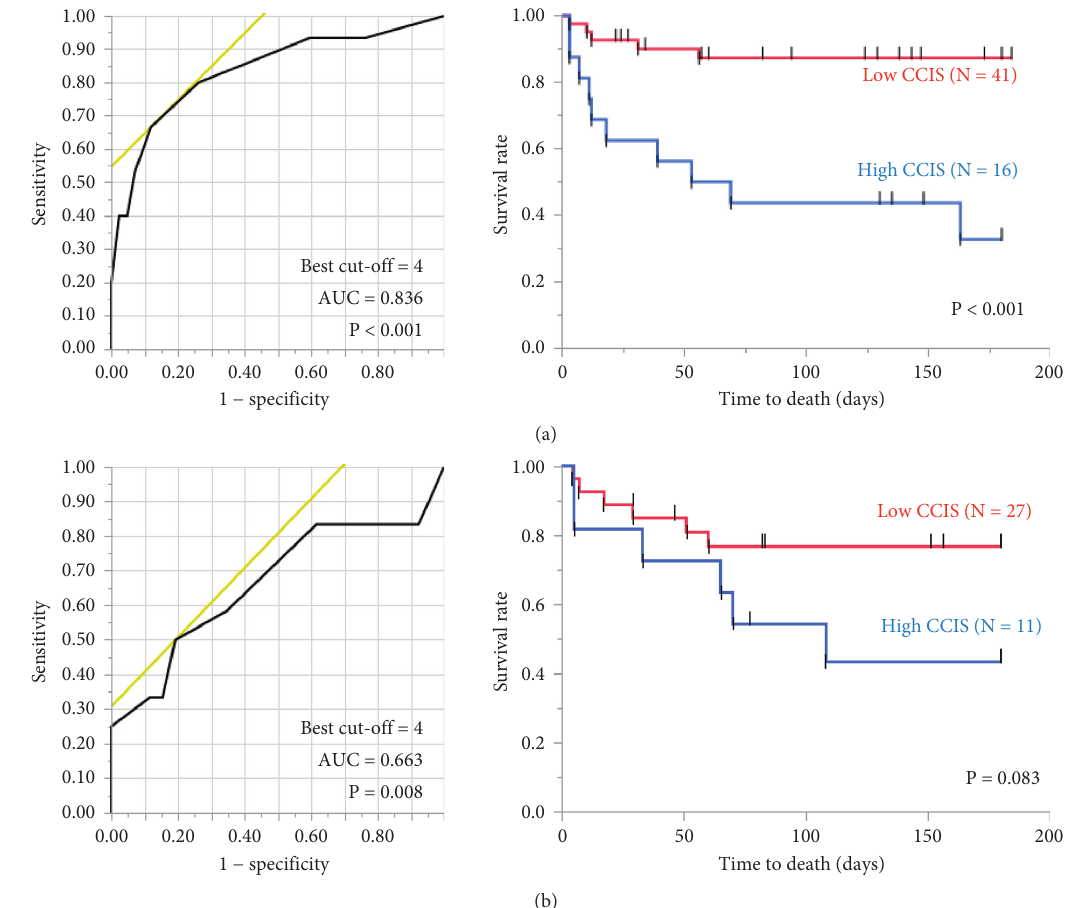
Figure 3: Relationship between 6-month mortality and CCIS. In the patients with low serum KL-6 levels, the AUC is 0.836 in the evaluation of CCIS as a predictor of 6-month mortality (a). The optimal cutoff CCIS for estimating 6-month mortality is 4 points ( P < 0.001). Log-rank tests show that the Kaplan–Meier survival curves of these groups differ significantly ( P < 0.001) (A). On the contrary, in the patients with high serum KL-6 levels, the AUC value is 0.663 in the evaluation of CCIS as a predictor of 6-month mortality (b). Log-rank tests show that the Kaplan–Meier survival curves of these groups do not differ significantly ( P � 0.083) (B). AUC: area under the ROC curve;